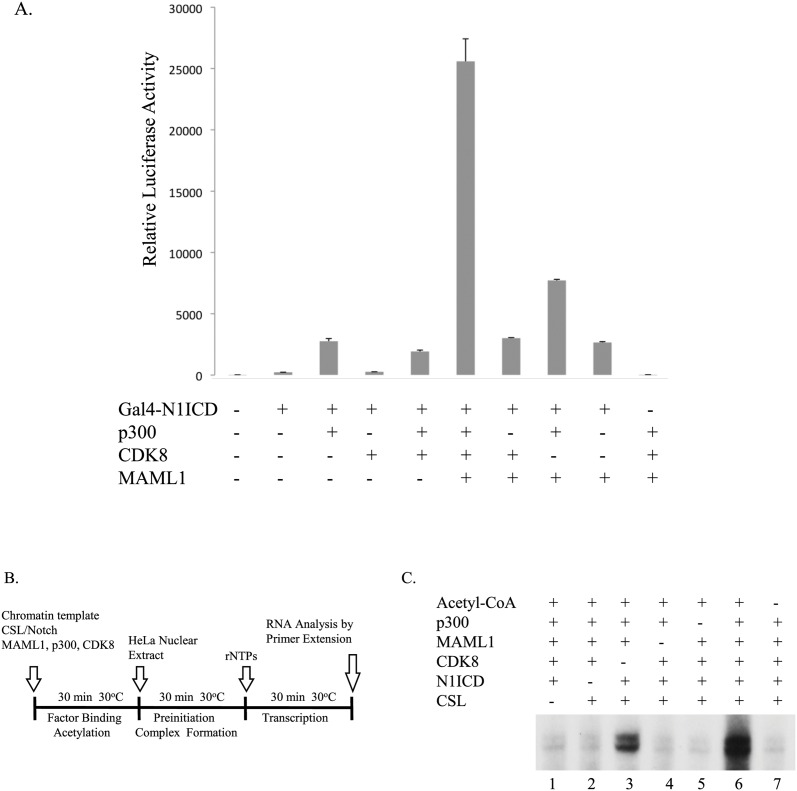
MAML1, CDK8 and p300 cooperatively stimulates Notch activity.
(A) HEK293 cells were co-transfected with a GAL4 luciferase gene and vectors expressing GAL4-Notch, MAML1, p300 and CDK8, as indicated in the figure. The data is presented as mean ± SD (n = 3). MAML1, p300, and CDK8 stimulate transcription in the presence of GAL4-Notch (*, p<0.0001). (B) Schematic of the in vitro transcription assay using chromatin templates. (C) Chromatin templates containing CSL binding sites were incubated with N1ICD, MAML1, CDK8, p300 and acetyl-CoA, as indicated.